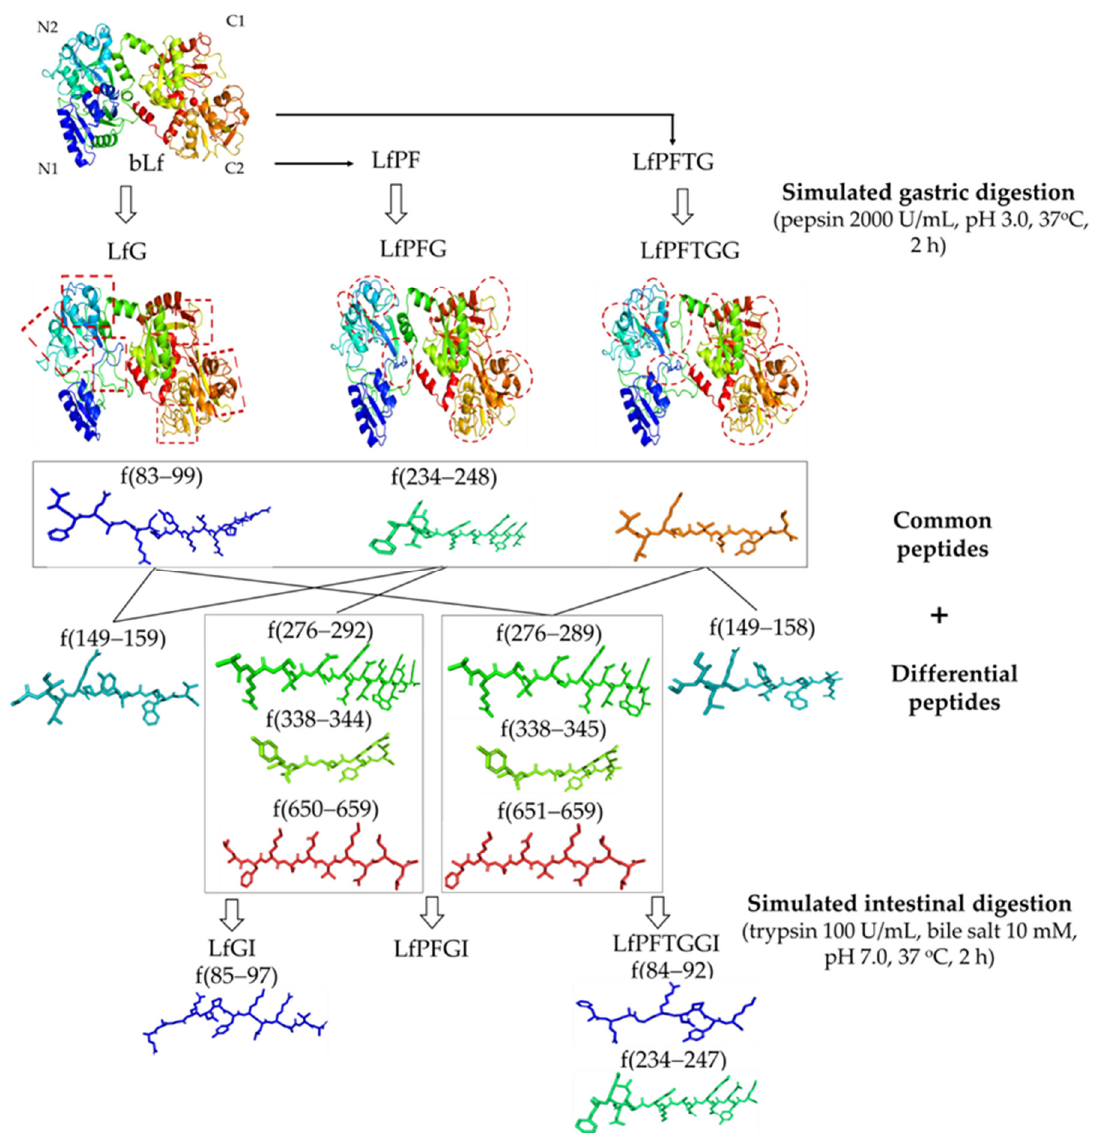
Figure 6. Active peptide production in the digests of bLf, LfPF complex, and LfPFTG complex during in vitro gastrointestinal digestion. Peptide fragments are in the same colors as in their parent bLf. Dashed frames indicate the action regions for pepsin.